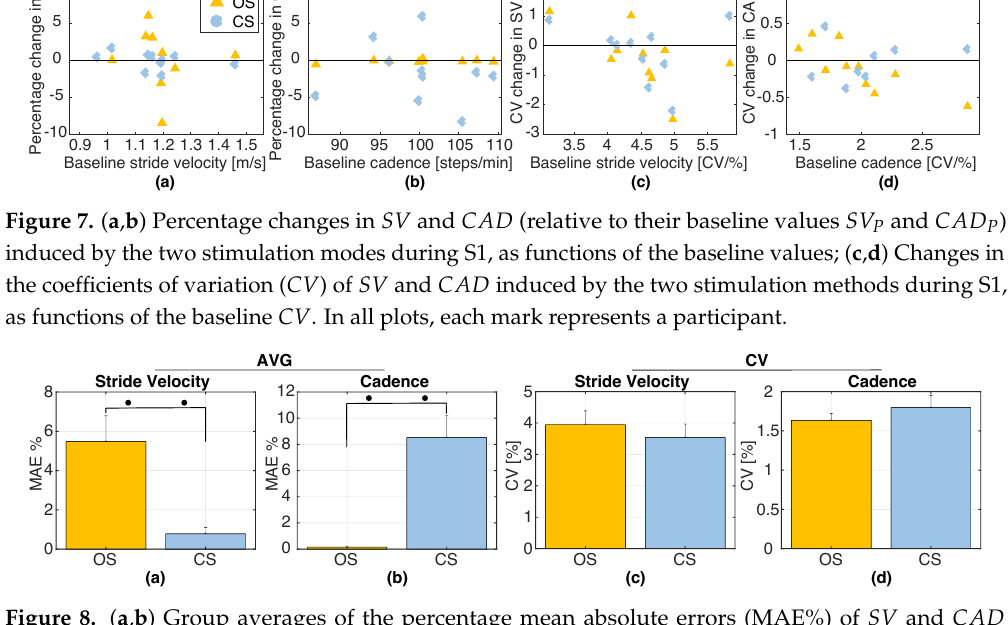
Figure 8. ( a , b ) Group averages of the percentage mean absolute errors (MAE%) of SV and CAD induced by the two stimulation methods, OS and CS, during S2. MAE% values are computed with respect to the target values SV T and CAD T ; ( c , d ) Coefficient of variation ( CV ) of SV and CAD induced by the two stimulation methods during S2. Error bars indicate ± 1SE. • • indicates p < 0.01.